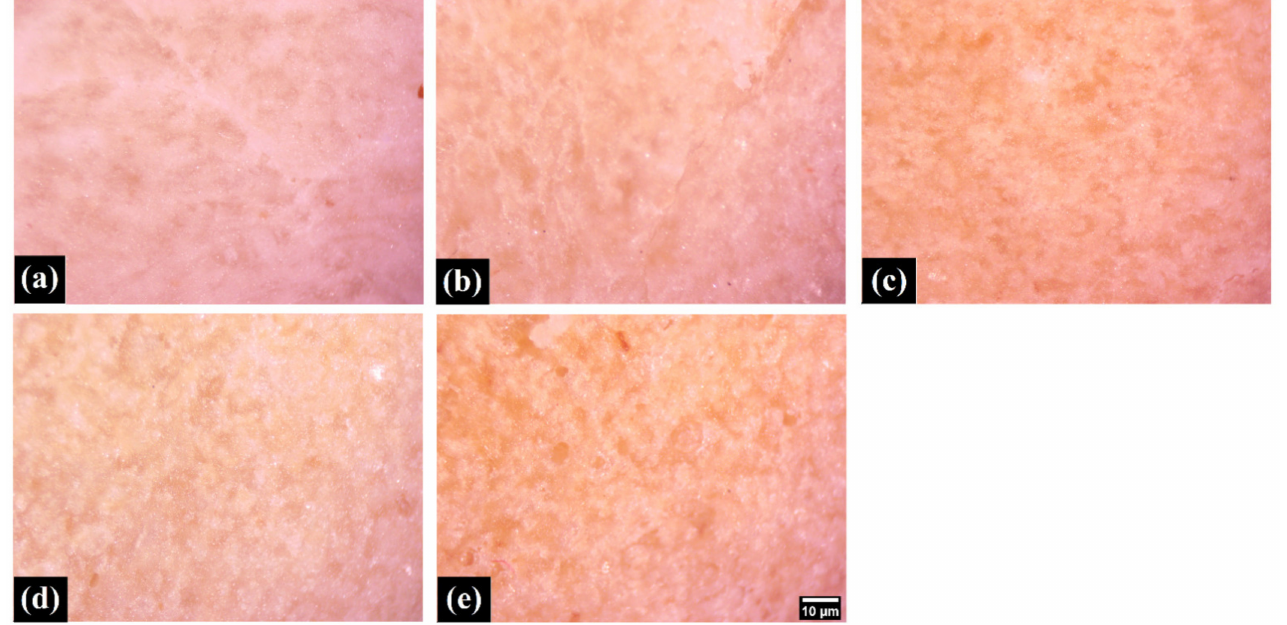
Figure 4. The micrographs of the various samples show the samples’ crust. ( a )WF0; ( b ) WF25;